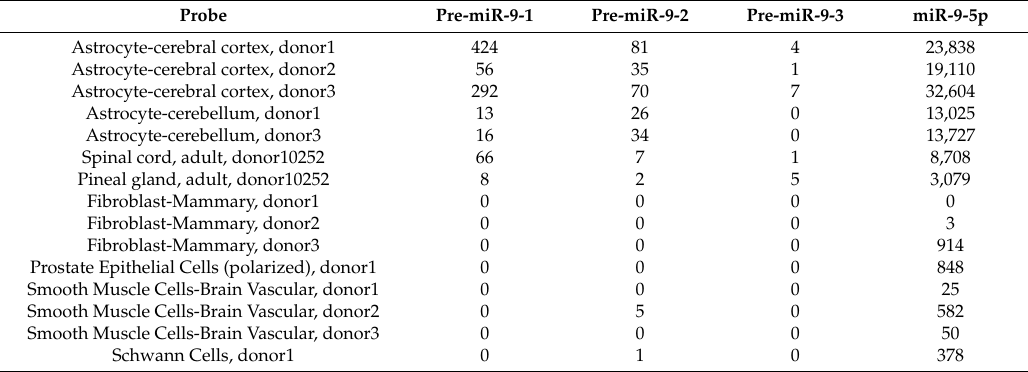
Table 1. Table presents expression patterns and relative abundance of pre-miR-9-1, pre-miR-9-2 and pre-miR-9-3, as well as miR-9-5p, functional element of all miR-9 in RISC complex, in several human cell types. Shown data suggest that miR-9-5p is predominantly created from pre-miR-9-1 (e.g., in cerebral cortex astrocytes or in spinal cord), but pre-miR-9-2 can also predominate in some cell types. Table was created based on FANTOM5 miRNA atlas (http://fantom.gsc.riken.jp/5/suppl/De_Rie_et_al_2017/).